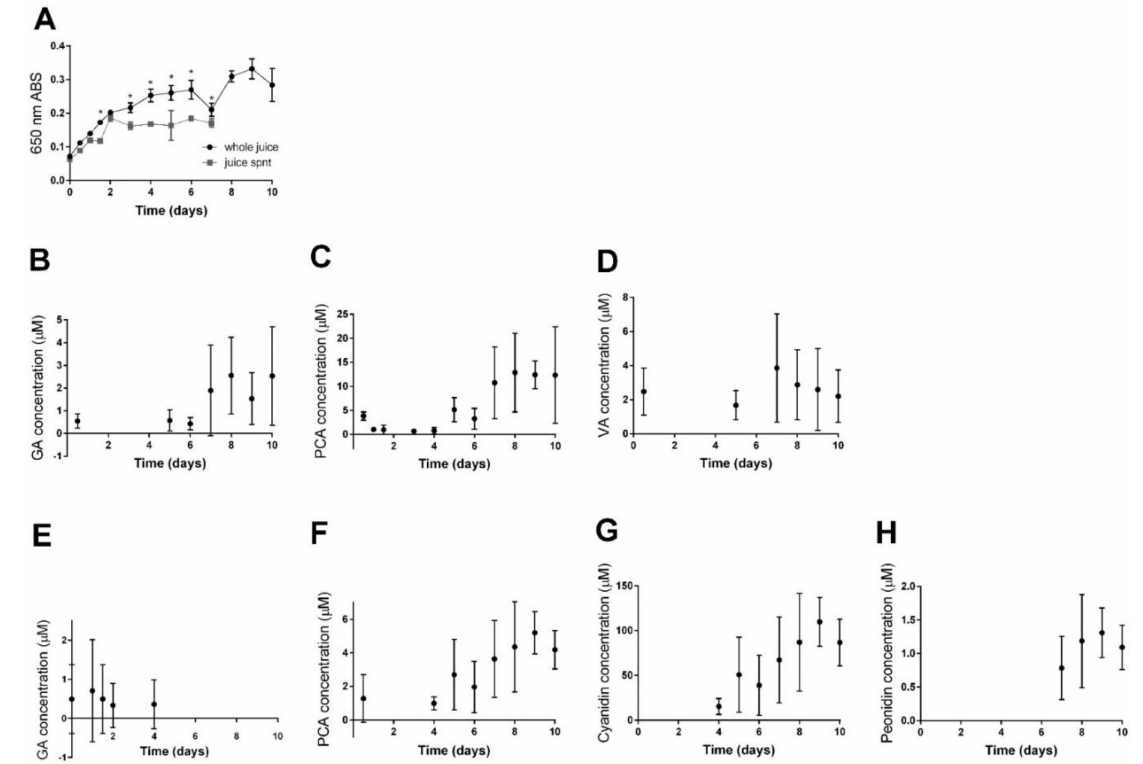
Figure 2. Time course of precipitate formation in cranberry juice and precipitate composition during accelerated aging at 50 ◦ C. ( A ) Light scattering (650 nm) in whole juice and centrifuged juice supernatant (spnt). Absorbances of whole juice and juice spnt were statistically different at indicated (*) time points between 0 and 7 days of accelerated aging according to two-way ANOVA with Sidak’s multiple comparisons test ( p < 0.0001 for Time, p < 0.0001 for Sample type, and p < 0.0001 for their Interaction). ( B – D ) Polyphenols detected in methanol extract of precipitate. ( B ) Gallic acid. ( C ) Protocatechuic acid. ( D ) Vanillic acid. ( E – H ) Polyphenols detected in hydrolysate of precipitate. ( E ) Gallic acid. ( F ) Protocatechuic acid. ( G ) Cyanidin. ( H ) Peonidin. Data points or analytes not shown in B – H were below limits of quantitation. Detection and quantitation limits are included in Supplemental Table